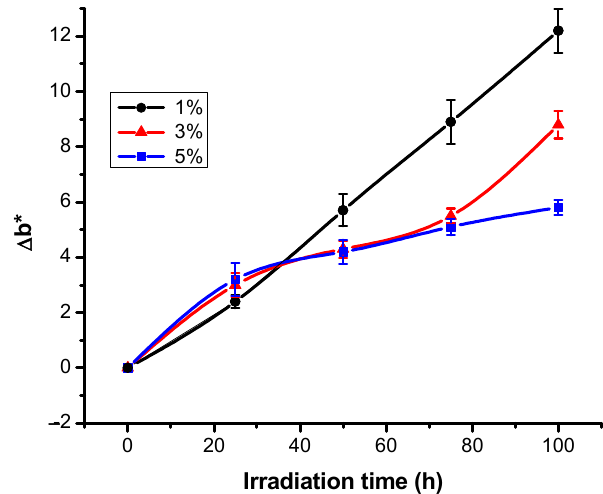
Figure 3. Variation of chromatic coefficients Δ b * with irradiation time for RB_204. From Table 2, one may see the influence of irradiation time and radiant exposure on the Δ E values. Thus, it can be observed that the increase of Δ E values varies proportion- ally with the irradiation parameters, regardless of the concentration of the dye solution used in the dyeing process (Figure 4).